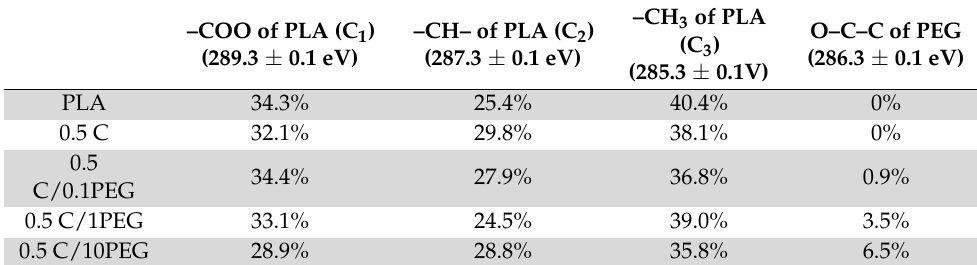
Table 2. Area ratios of characteristic peaks in C 1s spectra.